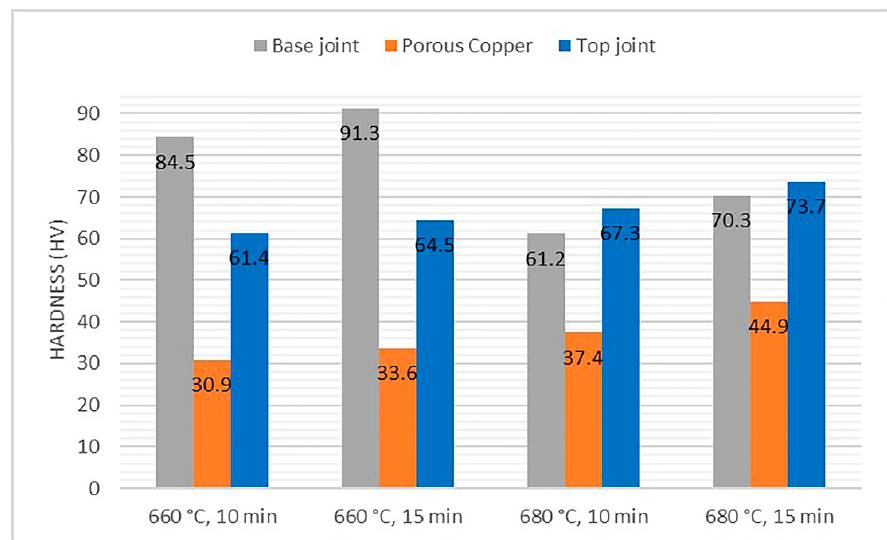
Figure 8. Microhardness values of samples brazed with different parameters.